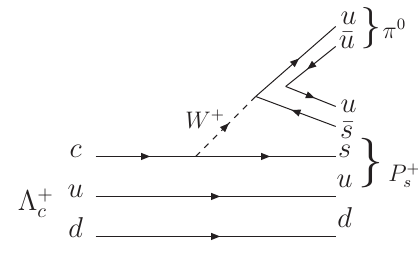
Figure 1. Quark level diagram for the Λ +